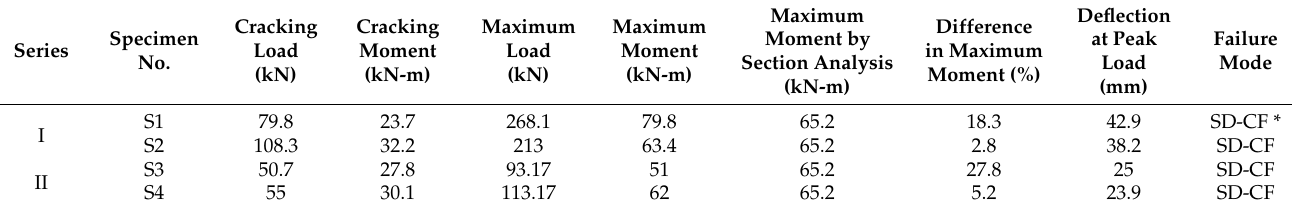
Table 2. The experimental results of the tested composite